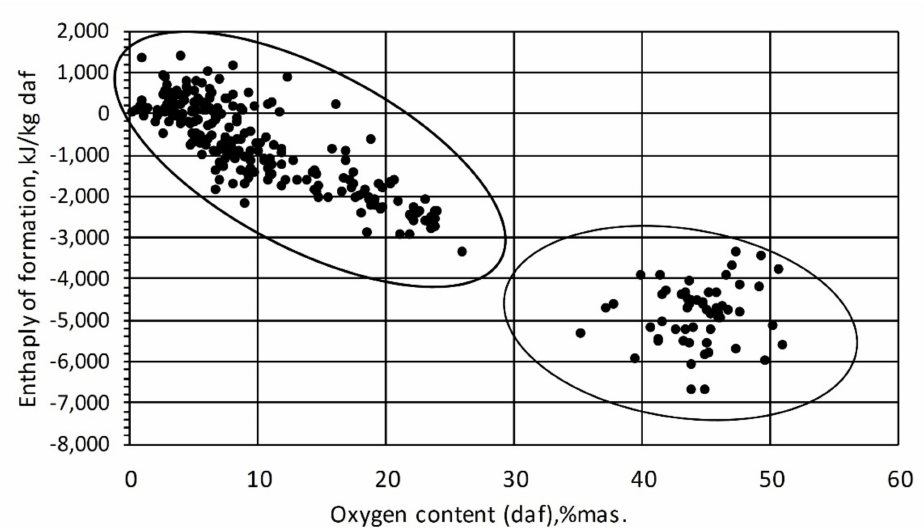
Figure 8. Enthalpy of formation against oxygen content.